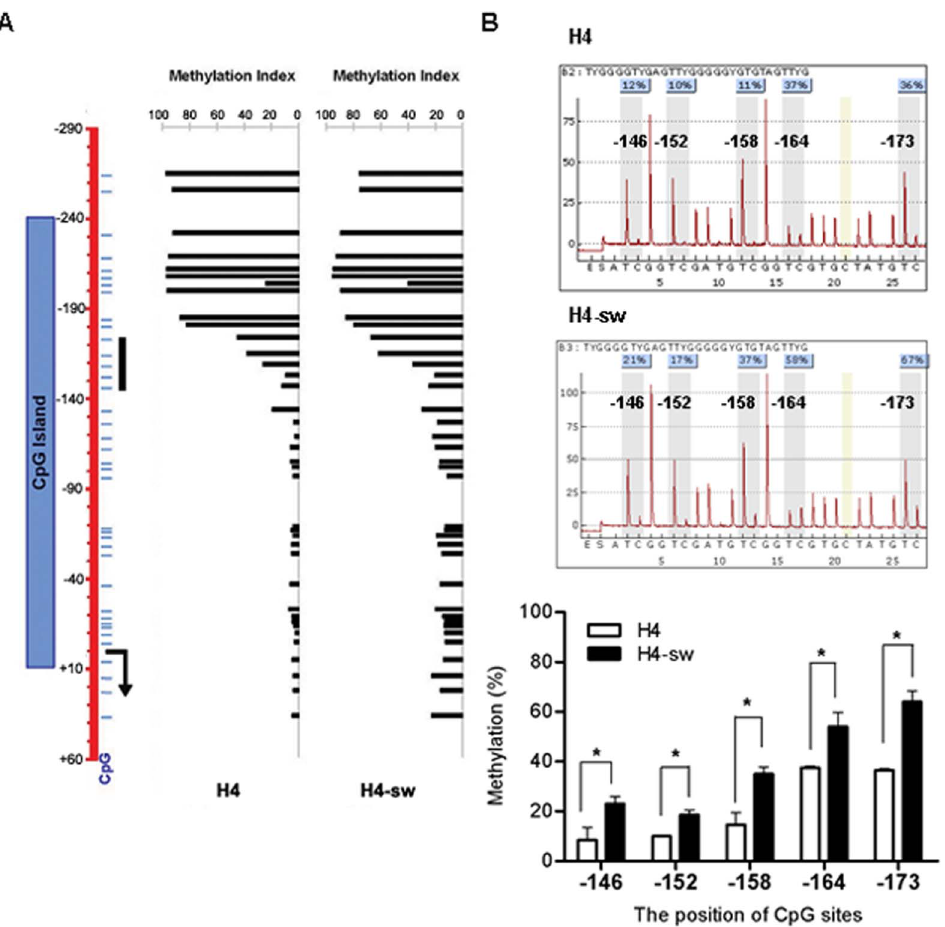
Figure 3. Hypermethylation of CpG islands within the IGFBP3 promoter in APP-Swedish mutant cells Schematic diagram of the genomic region ( + 60 to 2 290) of IGFBP3 that was analyzed for methylation status. The CpG island is represented as a box ( 2 240 to + 10). Thin horizontal lines indicate each CpG site. The bent arrow indicates the transcription start site ( + 1) and the thick vertical solid line indicates the target CpG sites for pyrosequencing analyses (A). Methylation status analyses were conducted using bisulfite sequencing analyses, the 454 GS-FLX system, and bisulfite pyrosequencing. Individual bars represent the percentage of methylation at the corresponding CpG site within the IGFBP3 promoter (A). Representative pyrograms are shown for each sample with the percentage methylation at each of the five CpG sites tested (B). Average percent methylation of triplicate pyrosequencing analyses at each of the five CpG sites are presented graphically (B). Data are shown as the mean 6 SD of triplicate experiments. Statistical analyses were performed using t -tests (* indicates p , 0.05). H4-sw, APP-Swedish mutant H4 cells.